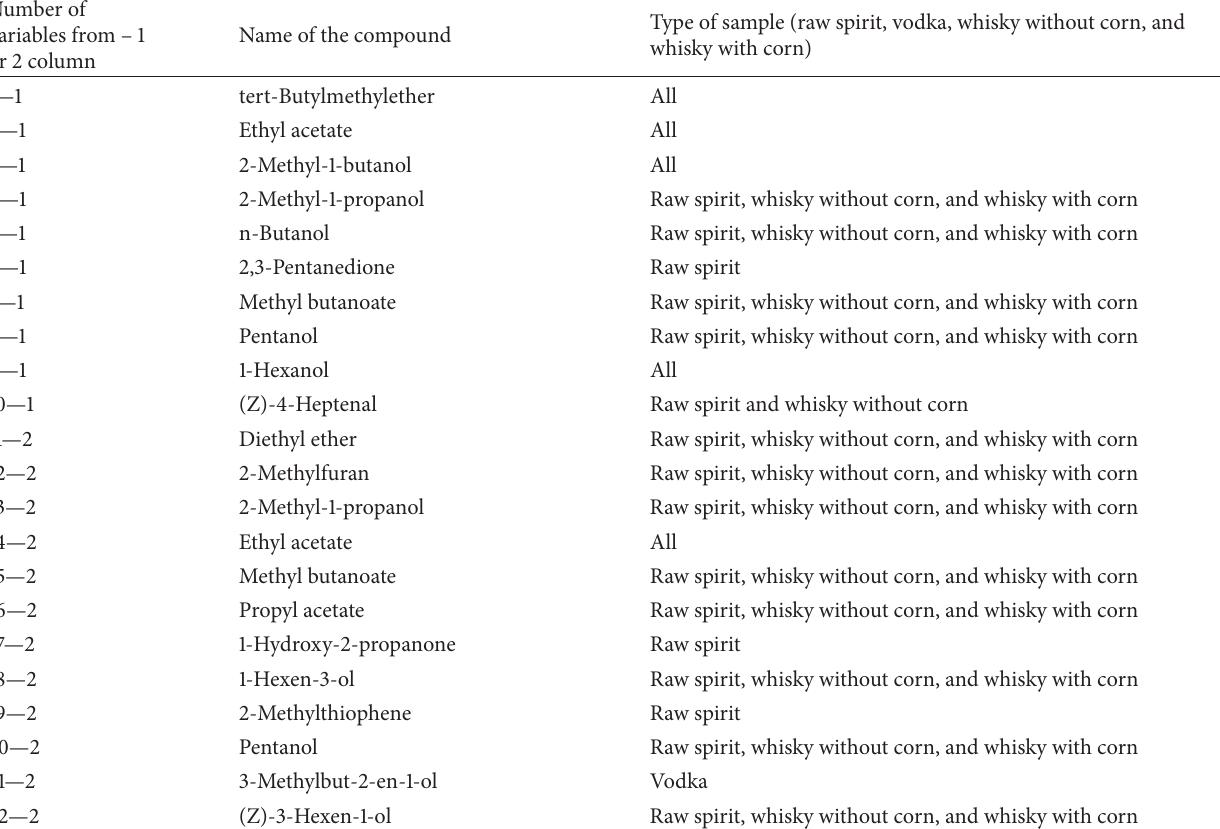
Table 2: Key chemical compounds (variables), which are important for sample